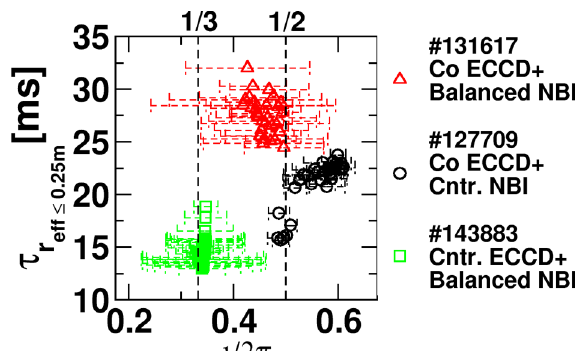
Fig. 17 : Local electron energy confinement time inside r eff =0.25 m ( t e_reff ≤ 0.25m ) plotted versus i /2 p near the core (averaged in in 0.10 m ≤ r eff ≤ 0.20